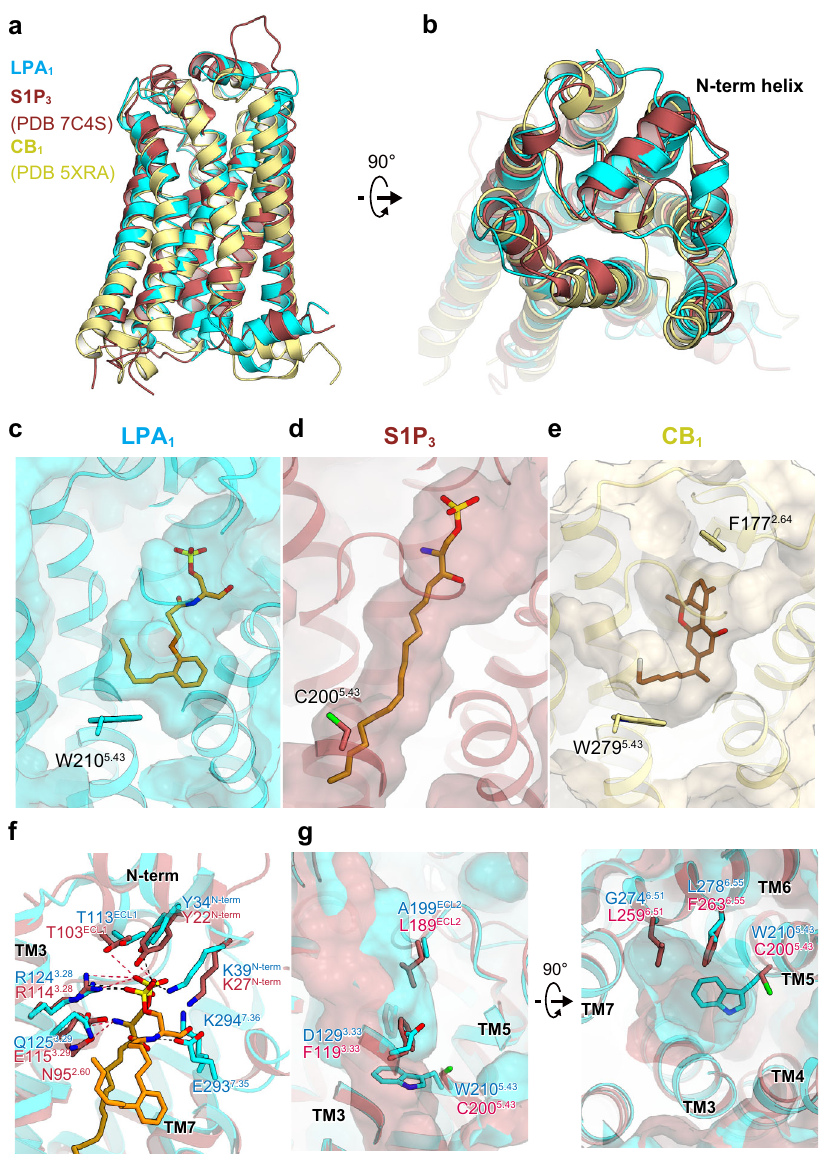
Fig. 3 | Comparison of lipid binding modes. a , b Superimposition of the agonist- bound LPA 1 , S1P 3 (PDB 7C4S), and CB 1 (PDB 5XRA) structures, viewed from the membrane plane ( a ) and the extracellular side ( b ). Cross sections of the ligand